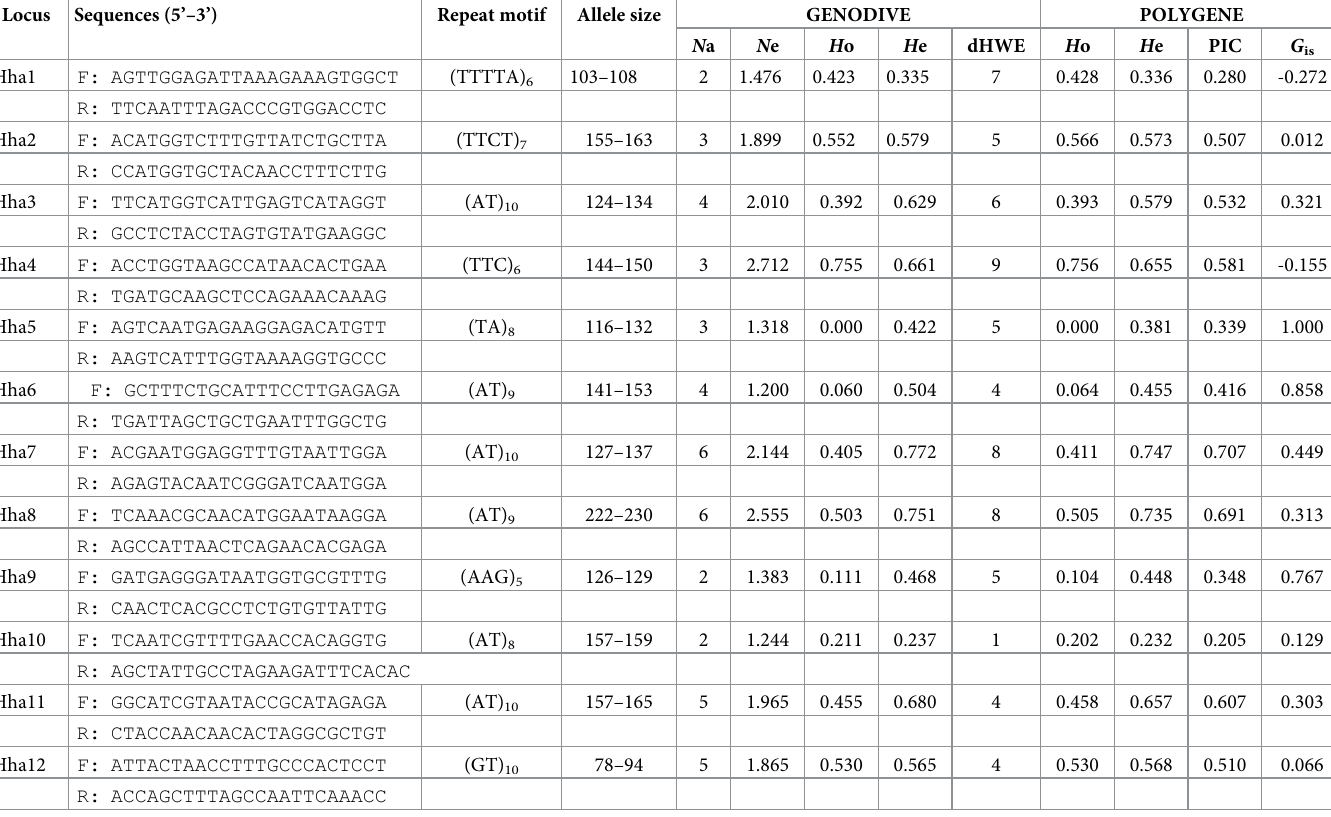
Table 2. Summary statistics for the 12 SSR markers across all Hopea hainanensis populations with metrics of genetic diversity estimated by GenoDive 3.04 and Polygene version 1.2b. Locus Sequences